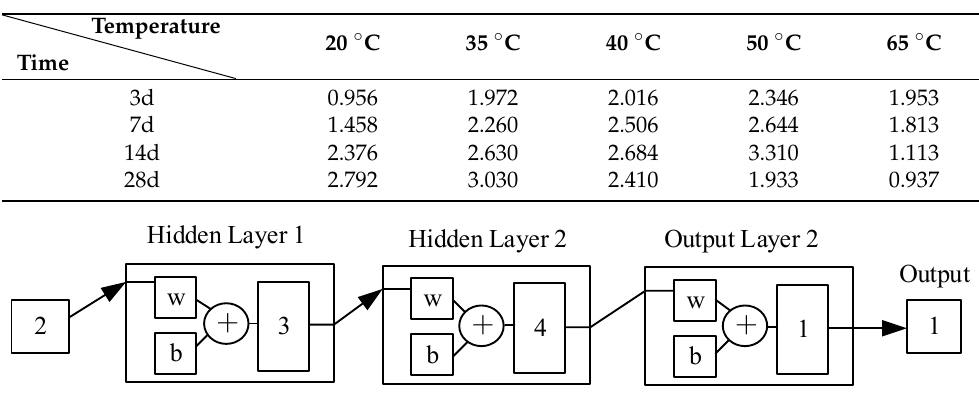
Table 3. CPB strength data under different curing temperatures (MPa).